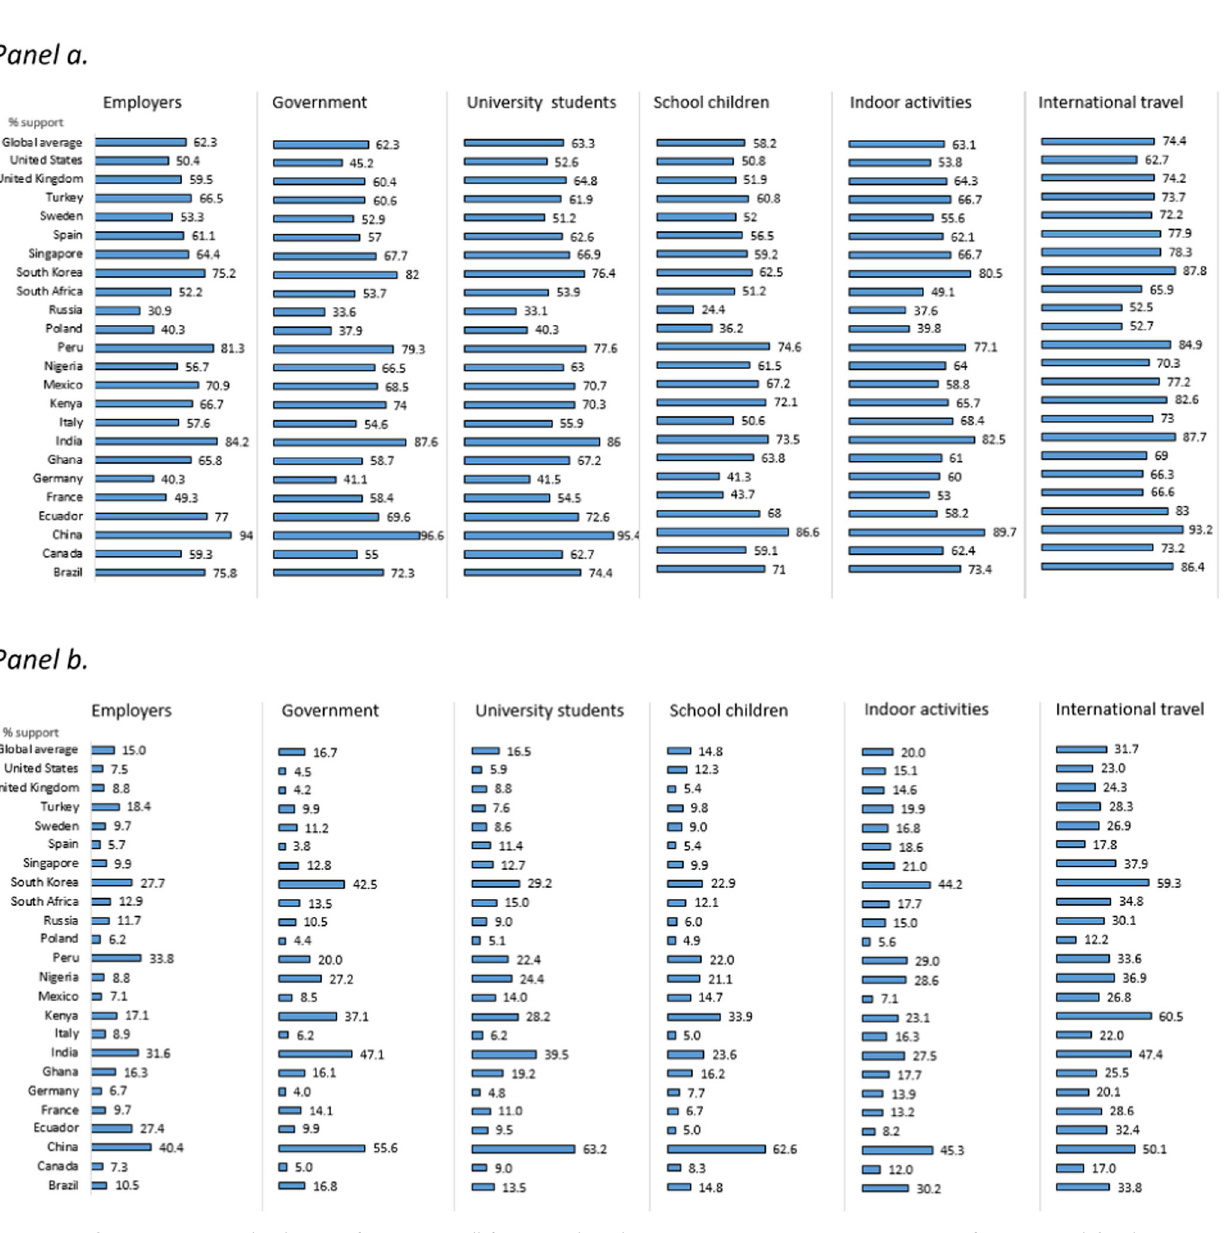
Fig. 6 Support for COVID-19 vaccination mandates. a Overall. b Among those hesitant to vaccinate against COVID-19. a , b Support is de fi ned as reporting “ strongly agree/agree ” with each